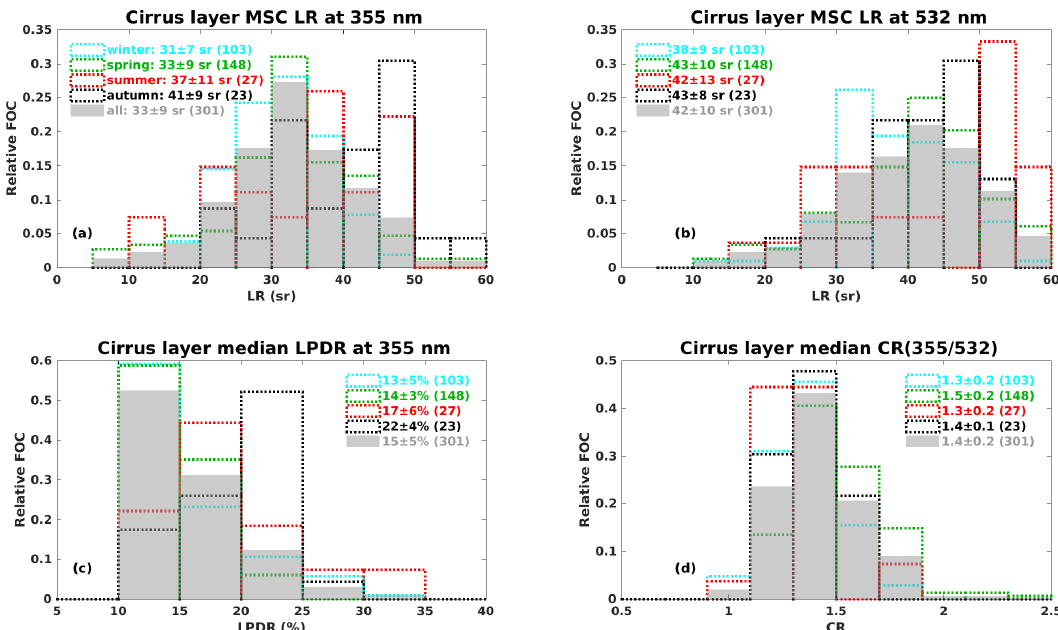
Figure 6. FOC distribution of MSC LR ( a , b ), LPDR ( c ) and CR ( d ). The median ± std (number of observations) is given in the legend. Only quality assured observations are